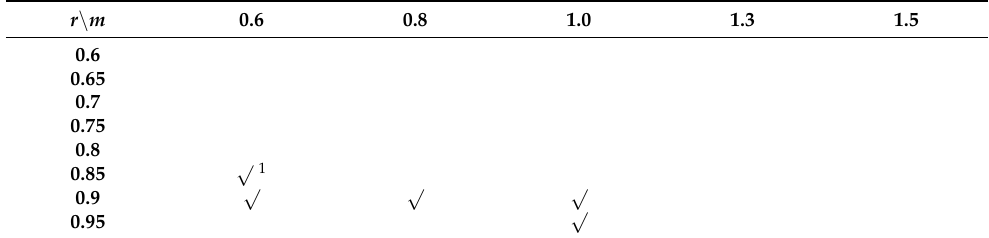
Table A1. The performance matrix for connections assembled by HEB160 column and IPE200 beam, without any web reinforcement, and steel grade is S275.